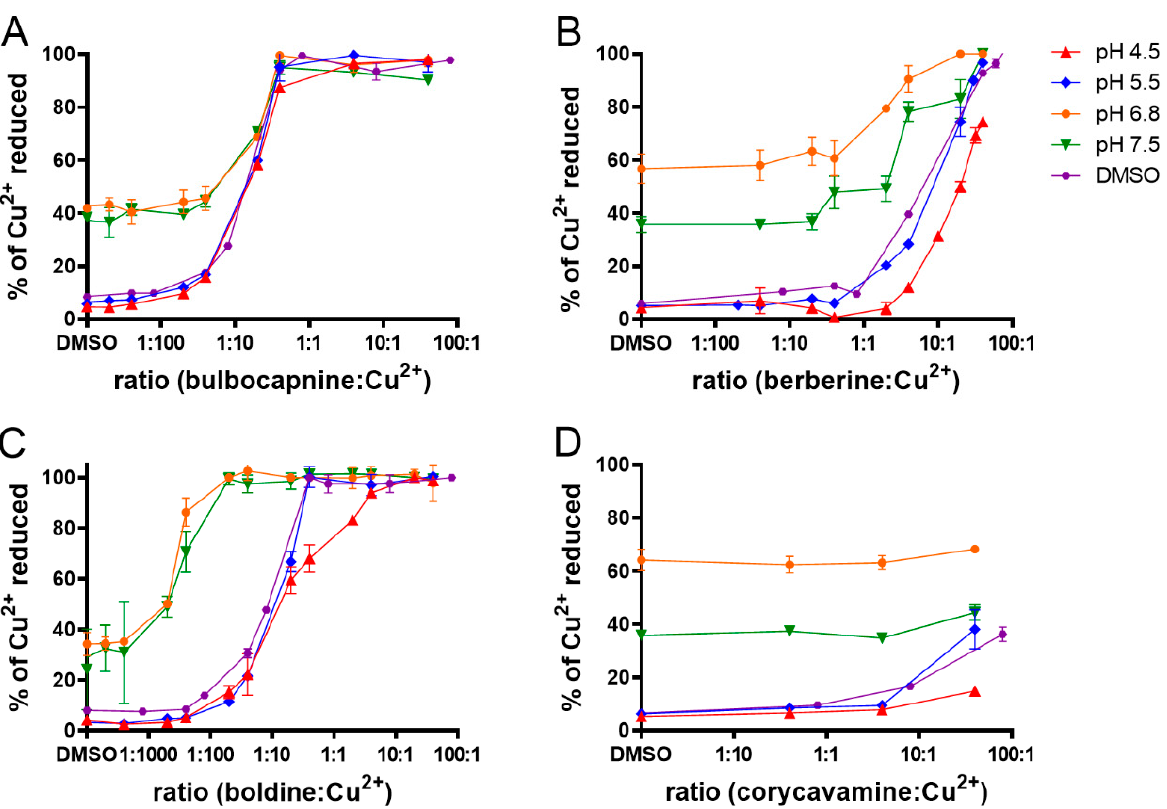
Figure 5. Examples of the reduction curves showing the relationship between the molar concentration ratio (alkaloid:Cu 2+ ) and the copper reduction activity at 5 min. ( A ): bulbocapnine; ( B ): berberine; ( C ) : boldine; ( D ): corycavamine. The data represent means ± SD.